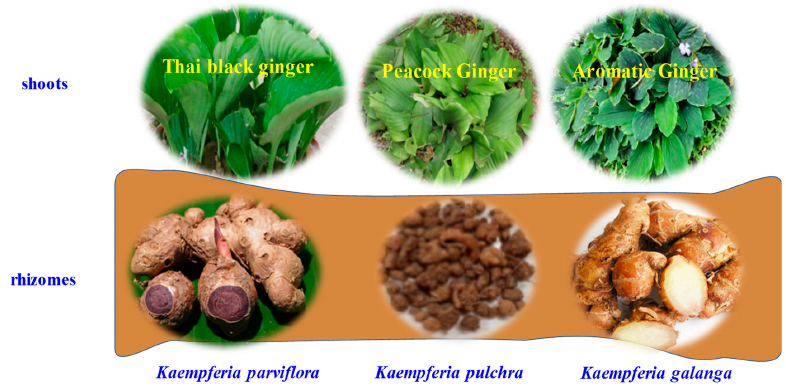
Figure 1. Traditional medicinal used Kaempheria